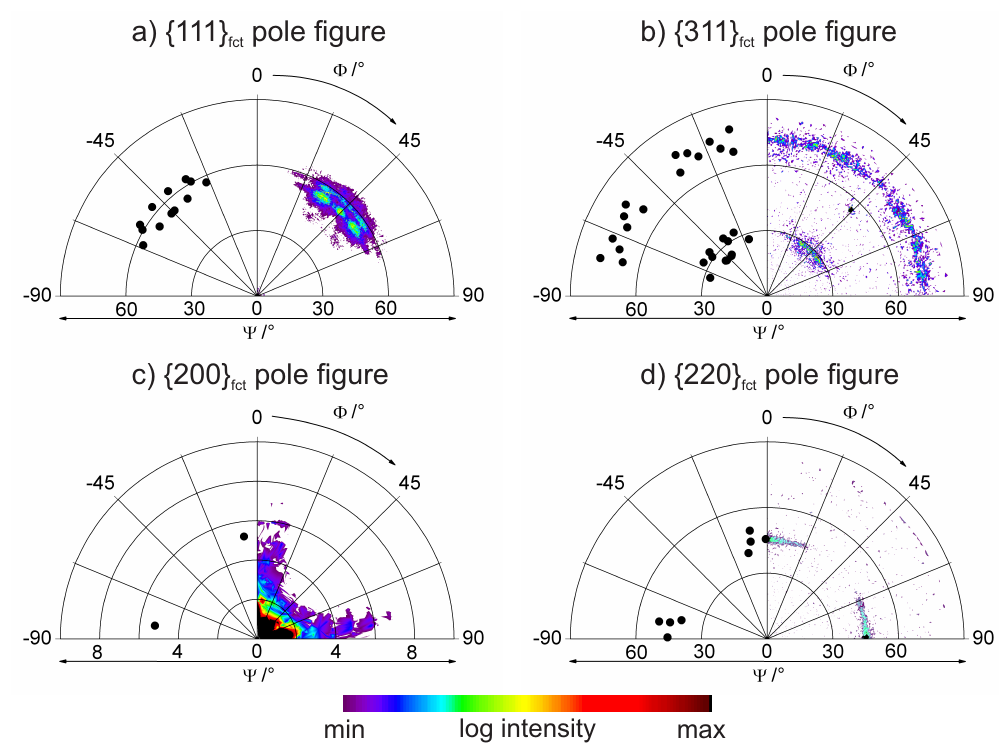
Figure 9. Comparison of measured pole figure of an annealed Fe (cid:104) 101 (cid:105) twins for c/a | with simulations of martensitic { 101 } fct fct { 111 } ; ( b ) { 311 } ; ( c ) { 200 } ; and ( d ) { 220 } fct fct fct fct